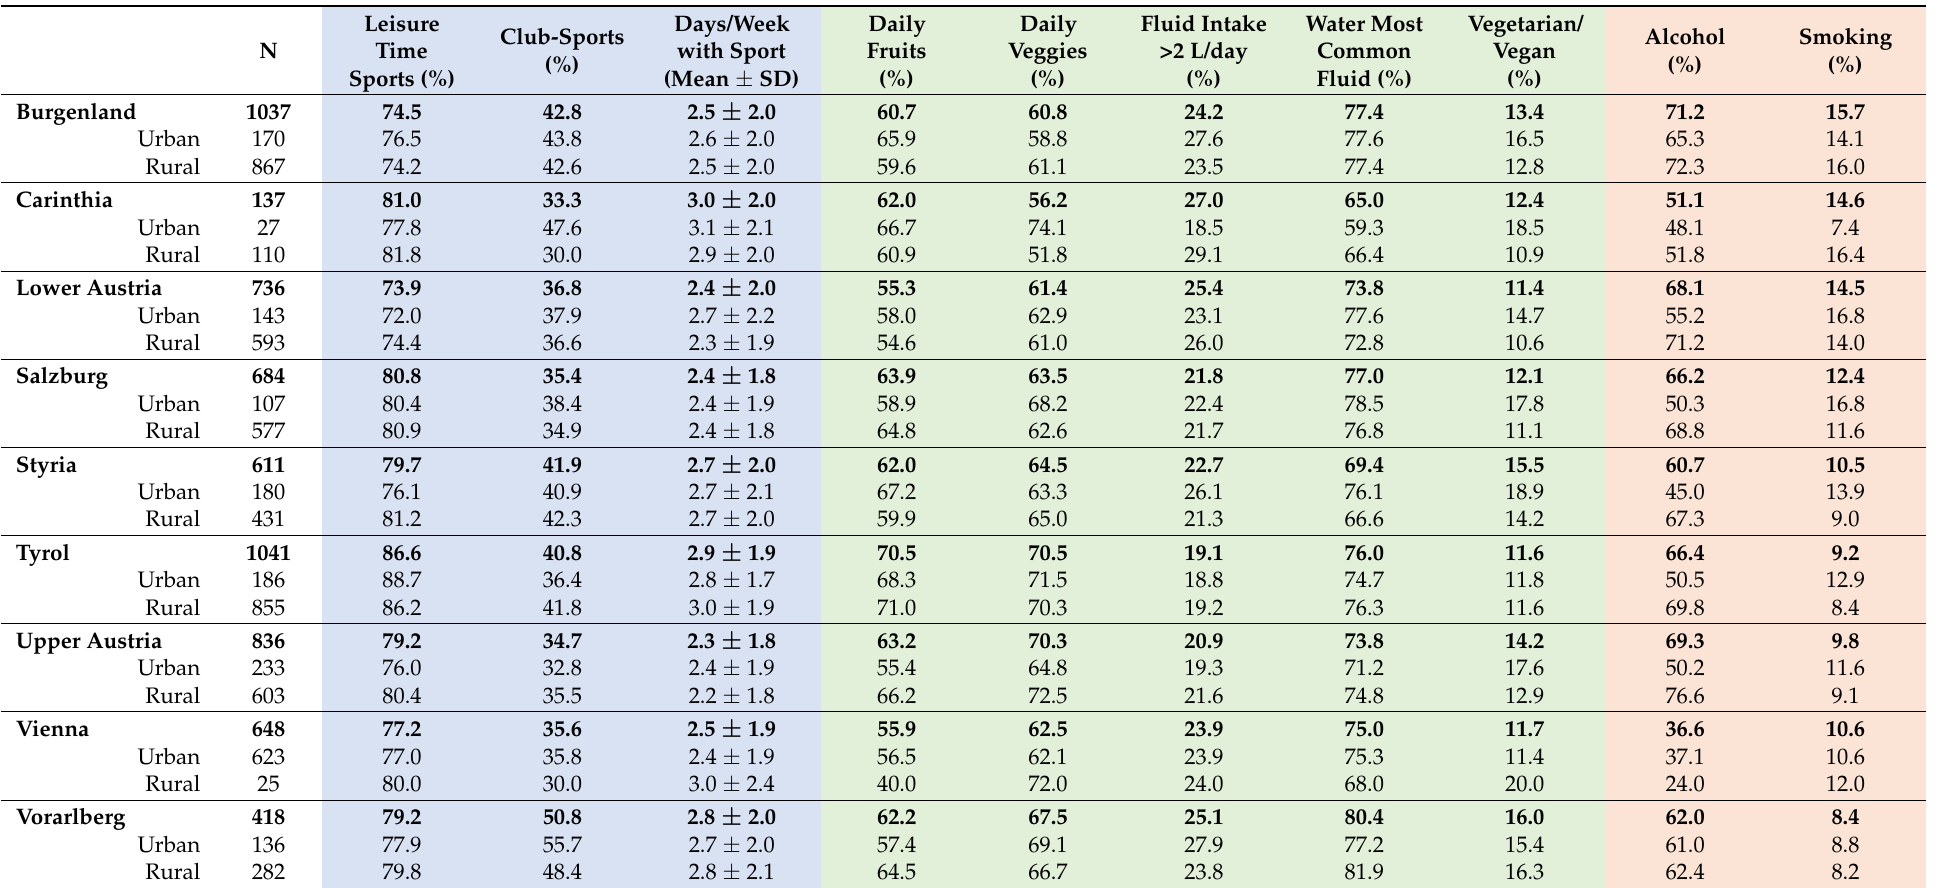
Table A4. Health behavior by federal state and living area in secondary level II students. Values are in prevalence (%) as well as means ± SD for days with sports.